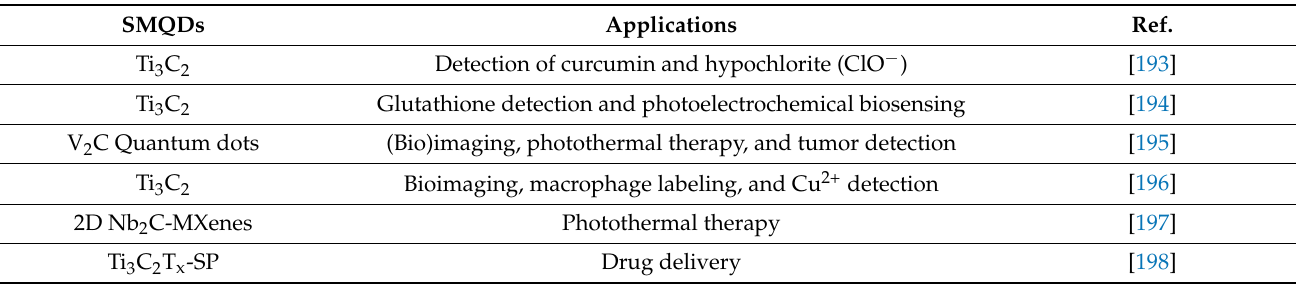
Figure 8. Biomedical applications of SMQDs. (Reprinted with permission [192] Copyright © 2022 by the authors. Licensee MDPI, Basel, Switzerland.) Table 3. The medical applications of SMQDs.